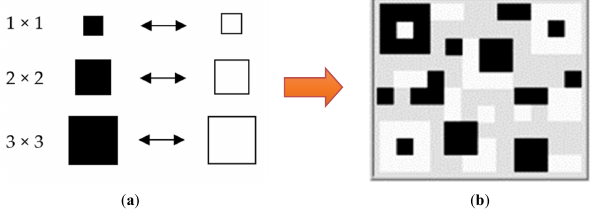
Figure 3. Proposed SSVEP stimulation pattern. ( a ) Three different sizes of the components inside stimulation pattern (1:10 mm). ( b ) Example of stimulation pattern using the QR code style.